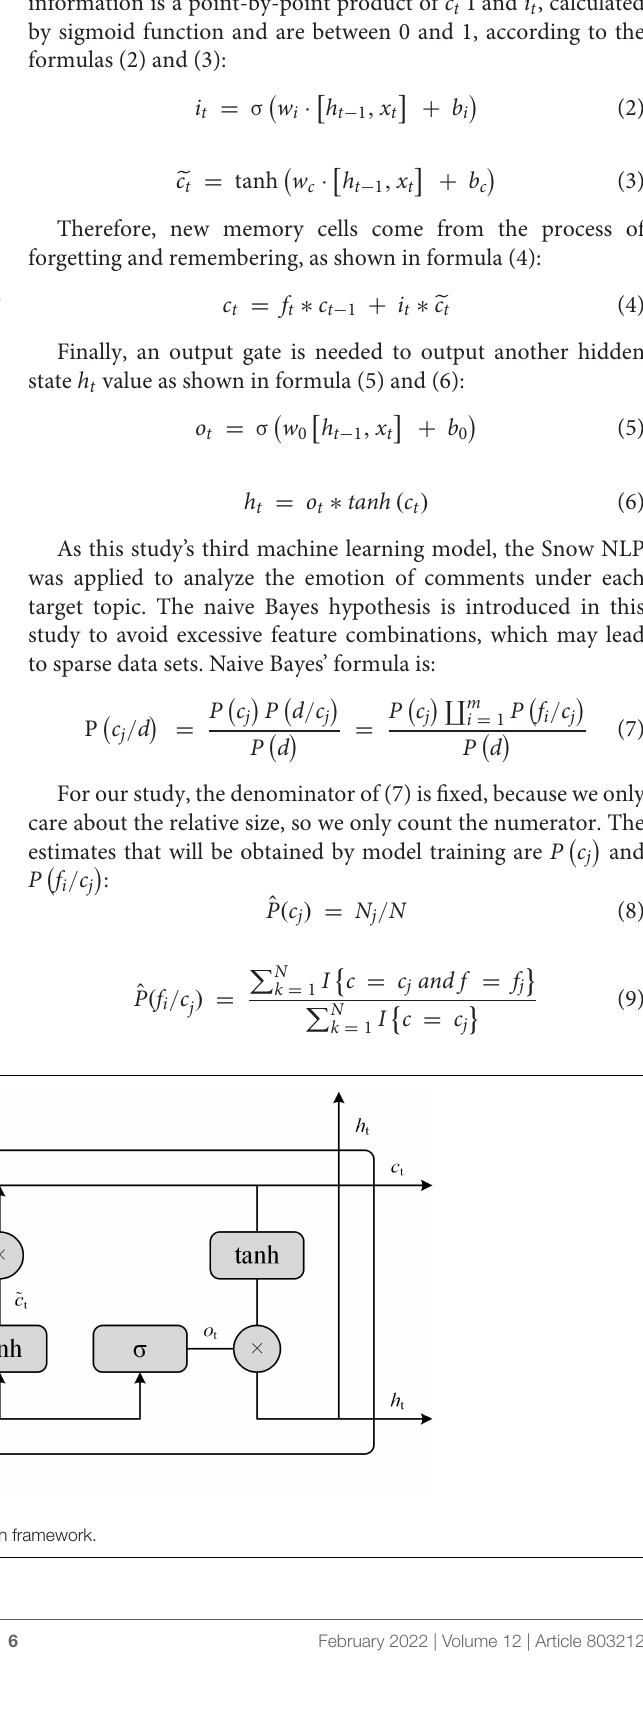
TABLE 1 | The variables of the Labeled LDA model. Symbol Explanation β k